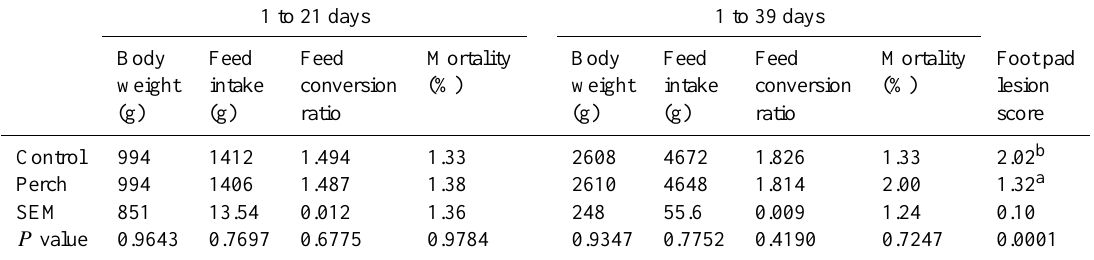
Table 2. Effects of perch availability on the performance indices and footpad lesion score of broiler chickens. 1 to 21 days